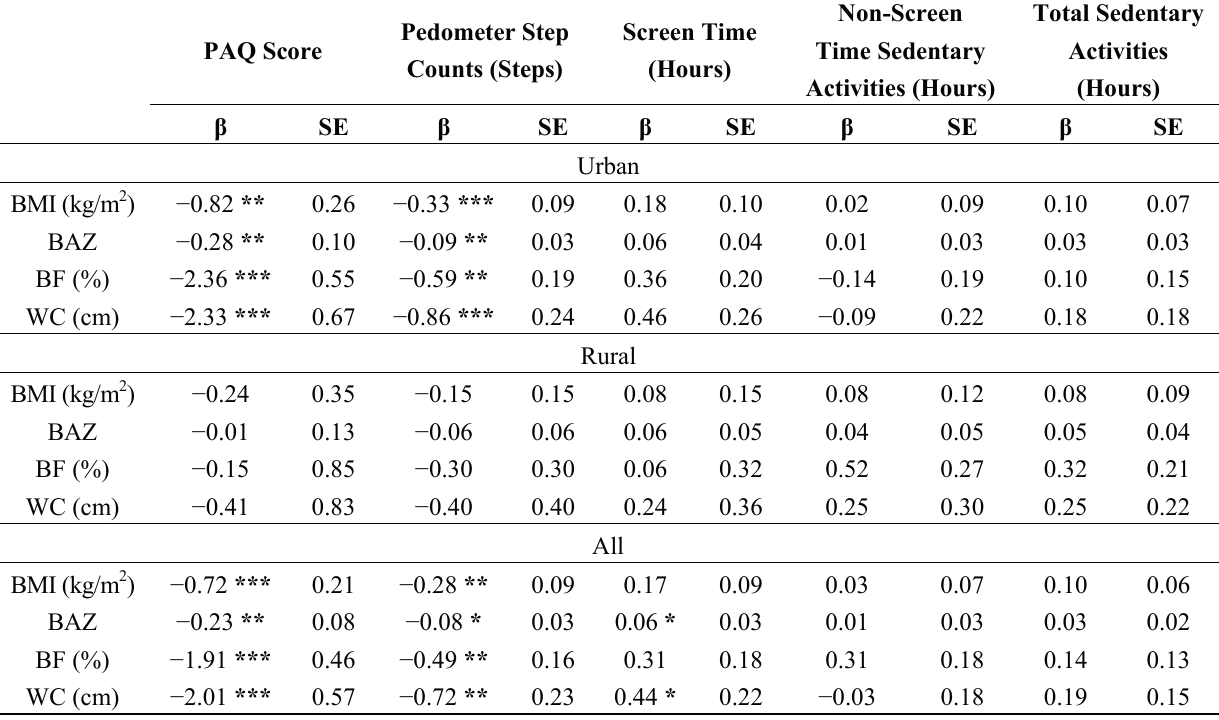
Table 5. Regression models of nutritional status of children based on daily physical activity and sedentary activities. Non-Screen Total Sedentary Pedometer Step Screen Time PAQ Score Time Sedentary Activities Counts (Steps) (Hours) Activities (Hours) (Hours)